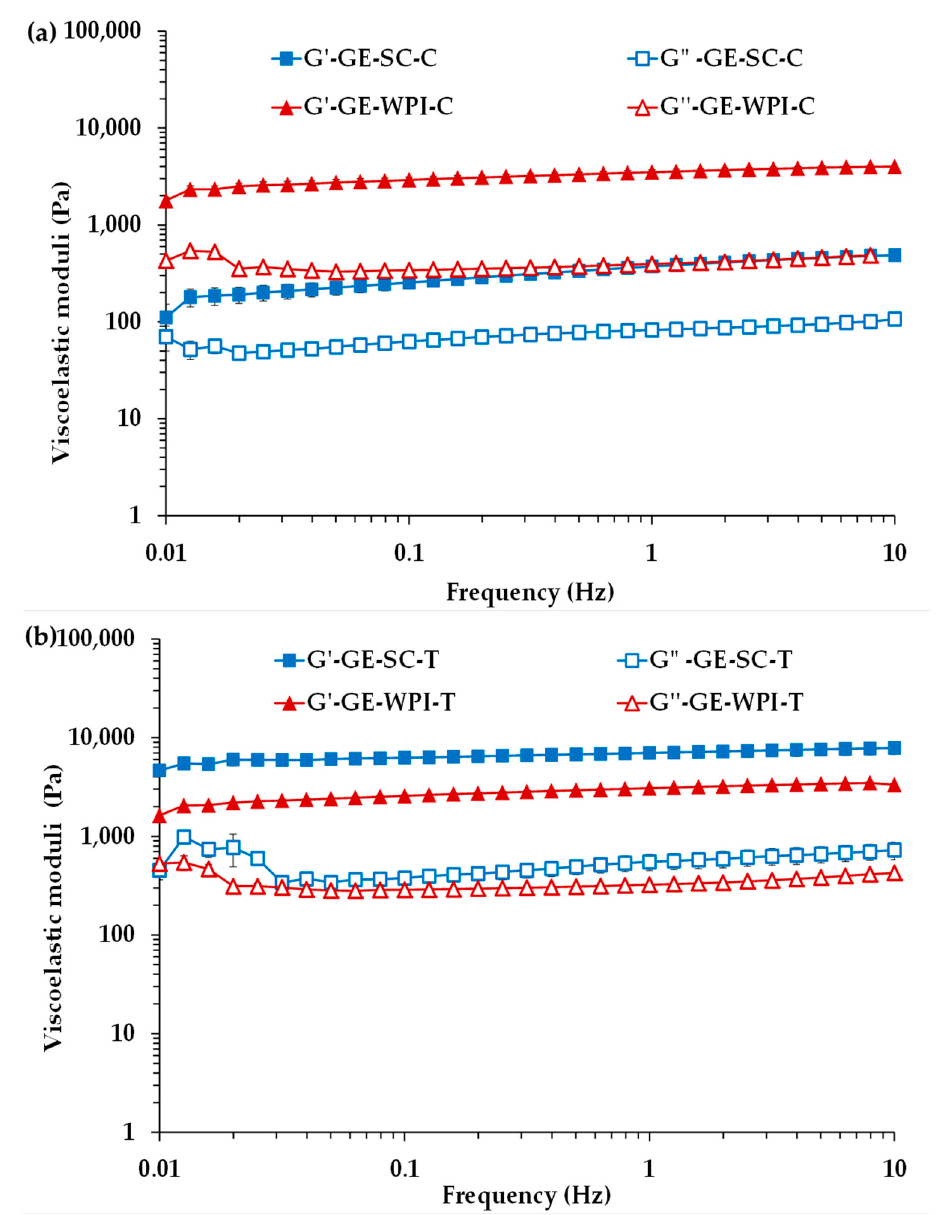
Figure 3. G ′ and G ″ as functions of frequency for gelled emulsions (GEs): ( a ) stabilized by SC and WPI without added condensed tannins (GE-SC-C and E-WPI-C); ( b ) stabilized by SC and WPI with added condensed tannins (GE-SC-T and GE-WPI-T).